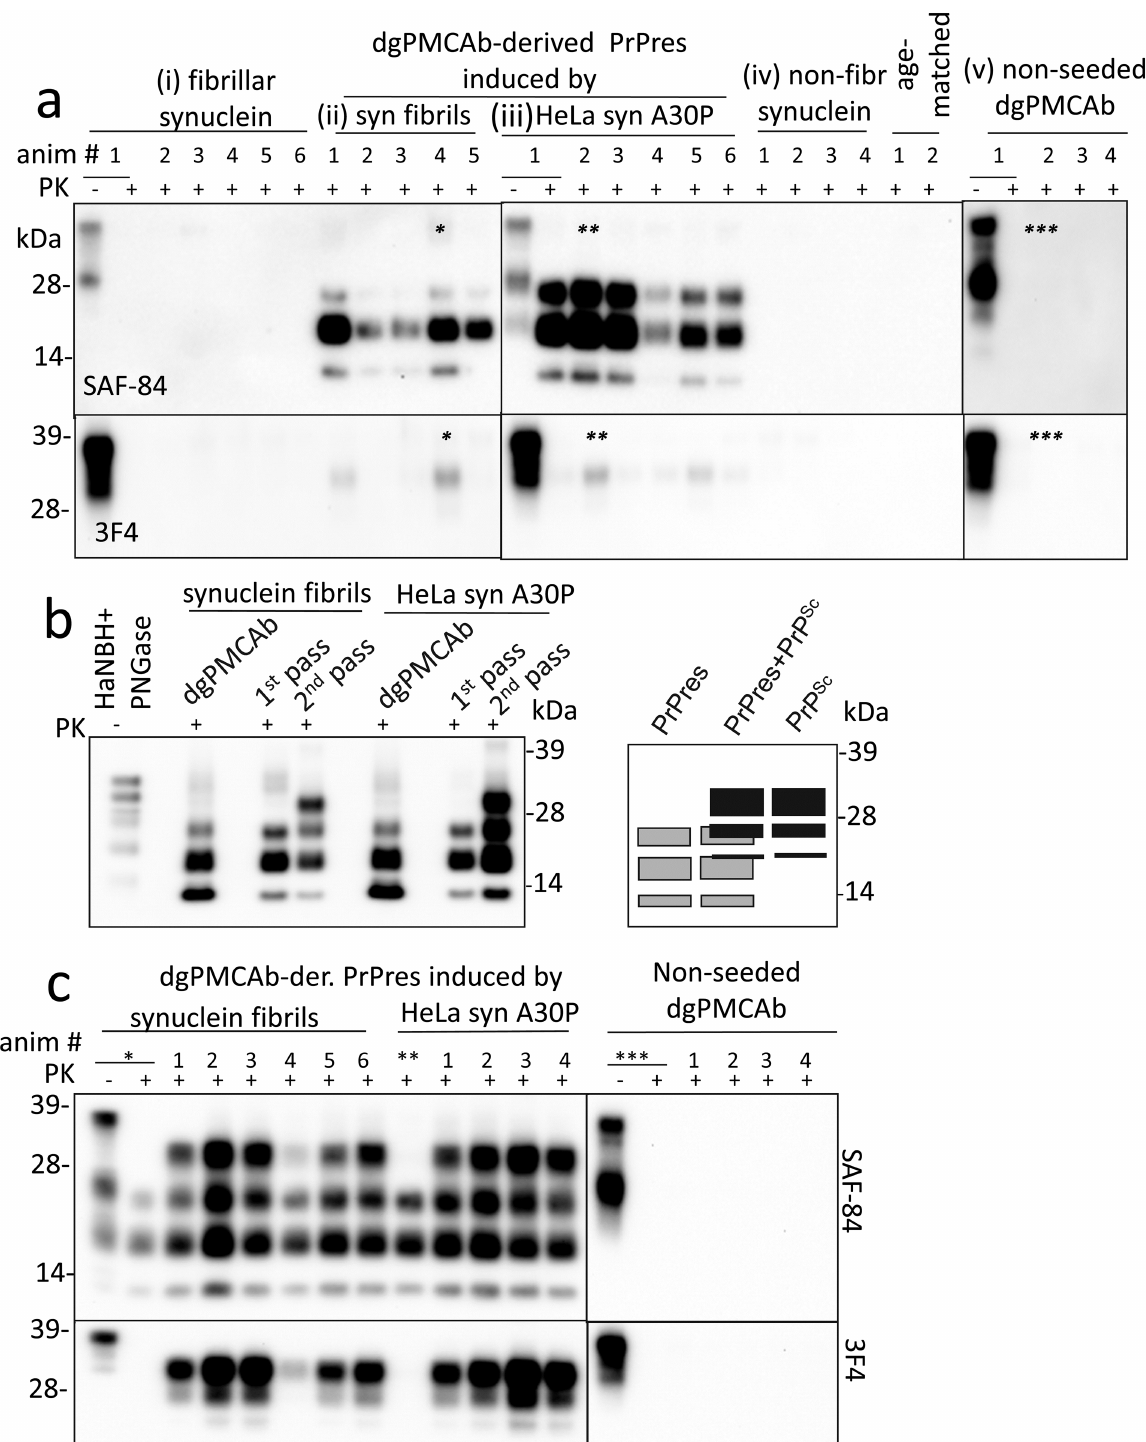
Fig 2. Bioassayof dgPMCAb-derived PrPres in Syrian hamsters. a Western blot analysisof brain material from hamsters inoculated IC with (i) fibrillar α -synuclein, (ii, iii) dgPMCAb-derived PrPres inducedby WT α -synuclein fibrils or lysates of HeLa cells expressingthe A30P variant, (iv) non-fibrillar α -synuclein, or (v) non-seeded dgPMCAb-derived material and stained with SAF-84 (top panels)or 3F4 antibody (bottom panels). Non-inoculated, age-matched animalswere examinedas a negativecontrol. Brain materials marked by asterisks were used for the second passage. b Left panelshows Western blot analysisof dgPMCAb-derived PrPres used